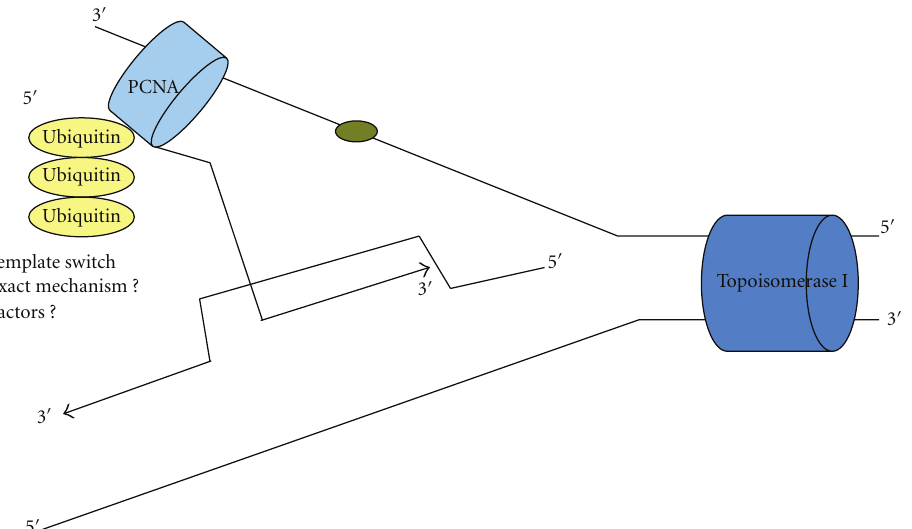
Figure 2: PCNA polyubiquitination mediates an error-free repair believed to occur due to template switch. The factors that perform this process are unknown. Holiday Junctions (HJs) appear be intermediates in this pathway